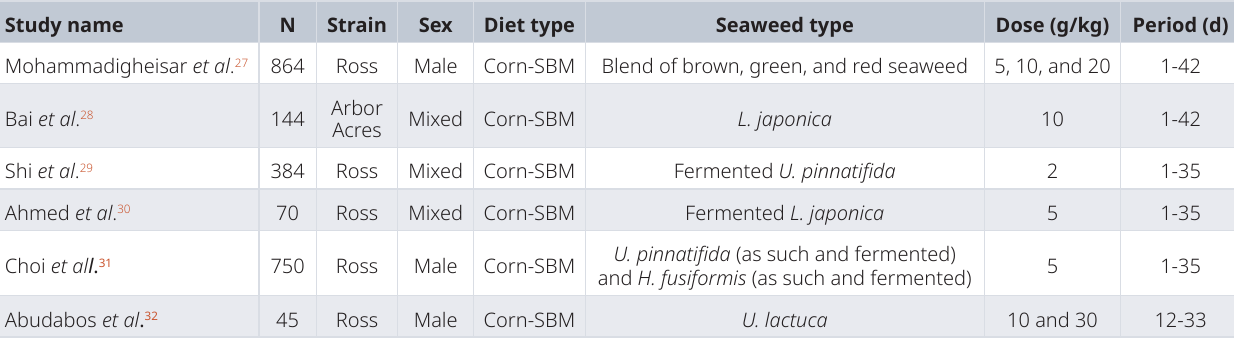
Table 3. Details of the included